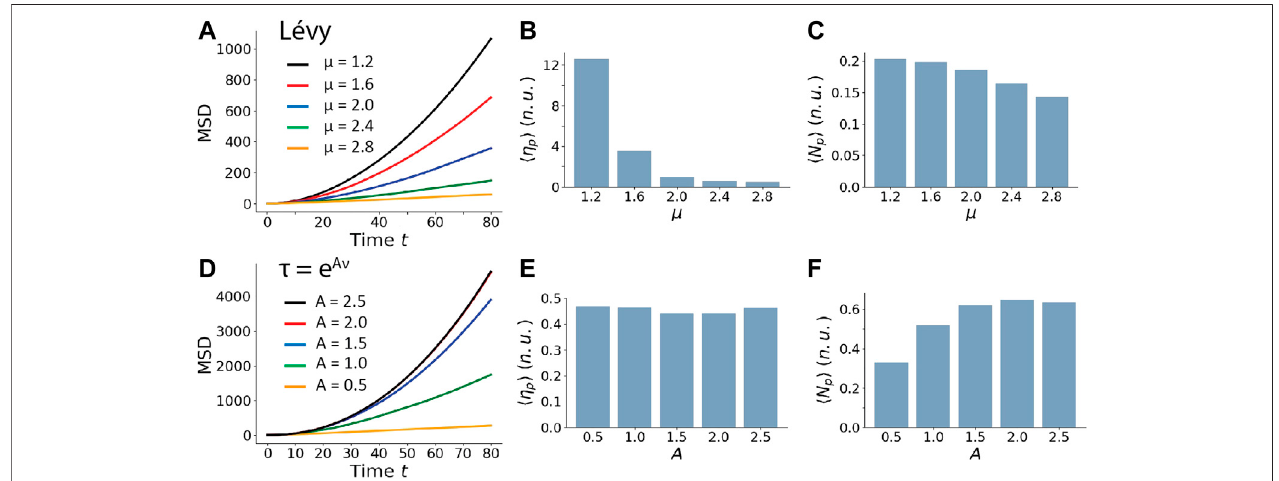
FIGURE6| Thein fl uenceofmodelparametersofLévywalkandnonlinearRWSPontheparticlemotility,searchingabilityandef fi ciencyinahomogeneousmedium. For a particle performing the Lévy walk, (A) , the MSD, (B) , the search ef fi ciency 〈 η p 〉 , (C) , the searching ability 〈 N p 〉 in fl uenced by the Lévy exponent μ . For a particle performingthenonlinear RWSP, (D) ,theMSD, (E) ,thesearchef fi ciency 〈 η p 〉 ,and (F) ,thesearchingability 〈 N p 〉 in fl uencedbythecoef fi cient A inthespeed-persistence relationship τ (cid:2) e Av . The target density ρ in (B, C, E) and (F) is 1.5. ( n . u . ) .